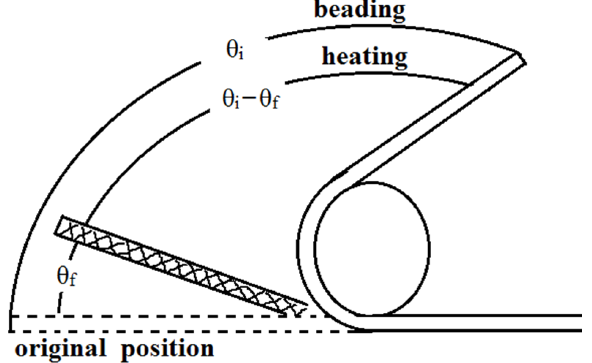
Figure 1. Shape memory model.